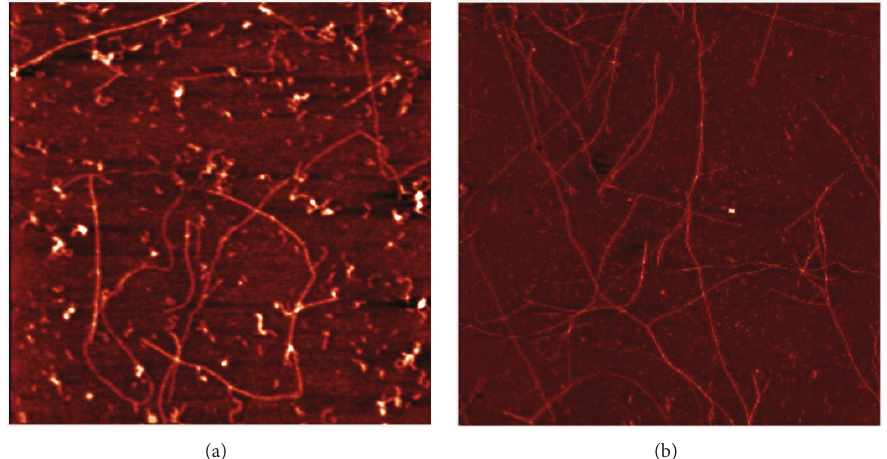
Figure 2: AFM characterization of HEWL fibrillation (a) without rifampicin in the incubation solution and (b) with rifampicin in the incubation solution. Scan size: 5 𝜇 m × 5 𝜇 m.